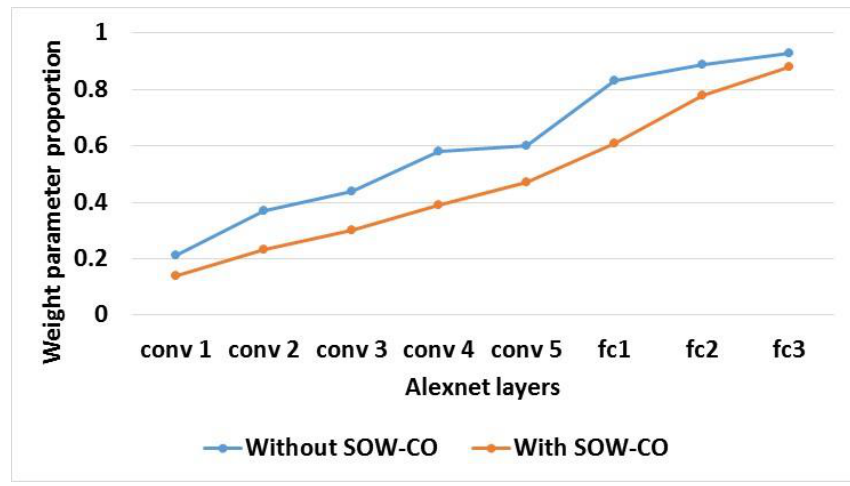
Figure 16. Graphical illustration of weight parameter proportion for Alexnet.